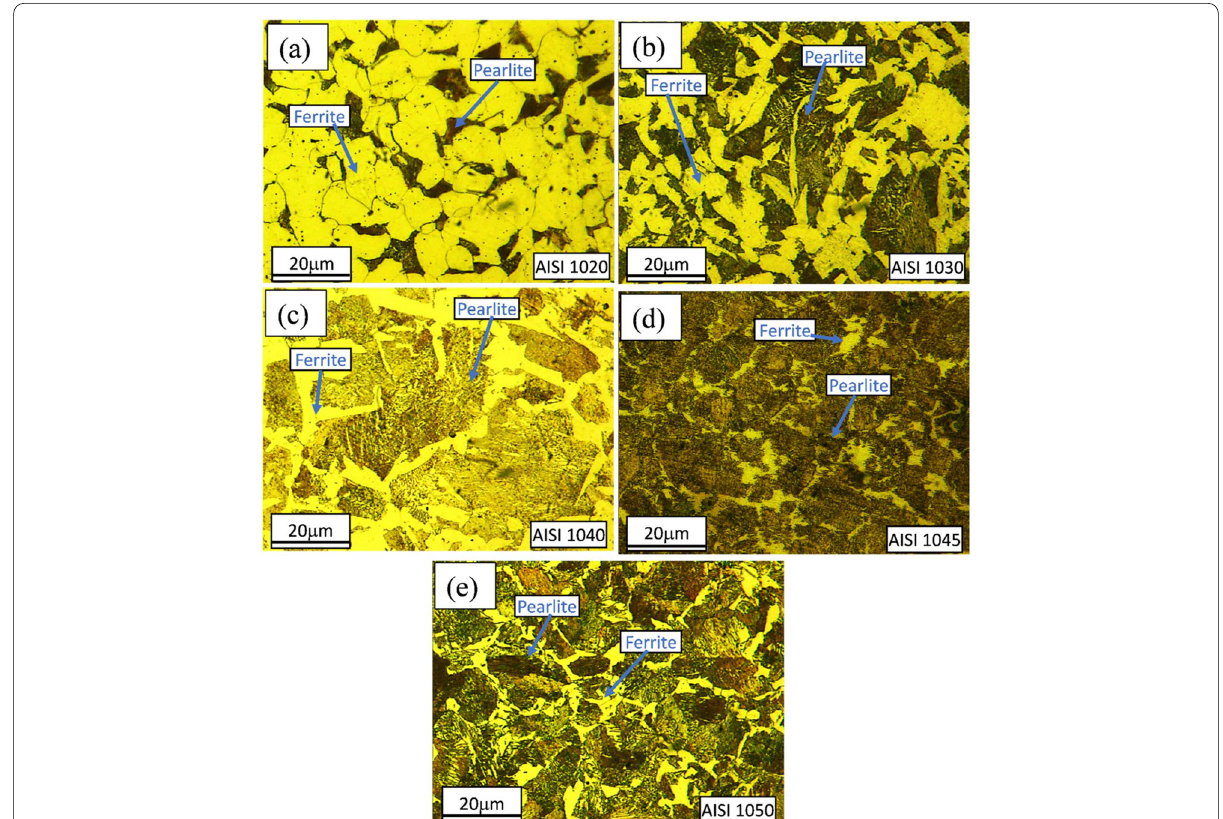
Fig. 3 Light optical micrographs of AISI a 1020, b 1030, c 1040, d 1045 and e 1050 plain carbon steels obtained after normalizing showing fine ferritic-pearlitic